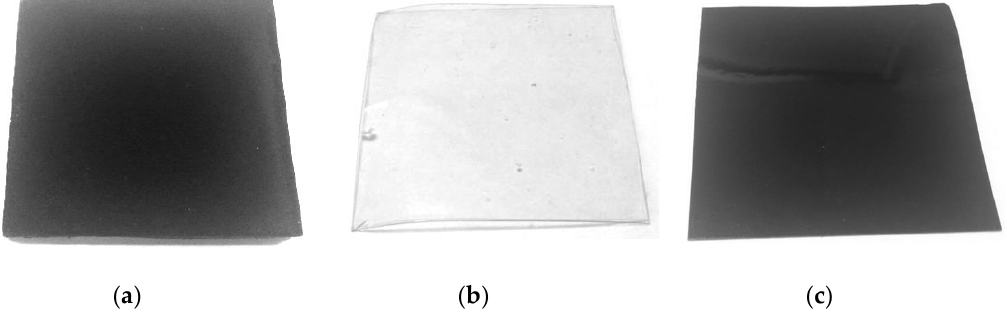
Figure 1. The view of the obtained samples: ( a ) the polyaniline (PANI) film on a polyethylene substrate; ( b ) the gelatin film; and ( c ) the gelatin-PANI composite film.